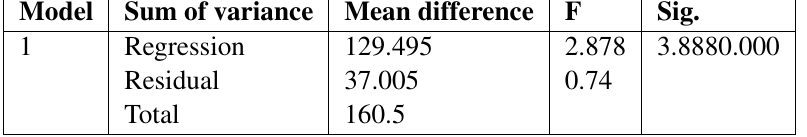
Table 5 Regression analysis variance of game winning factors and game